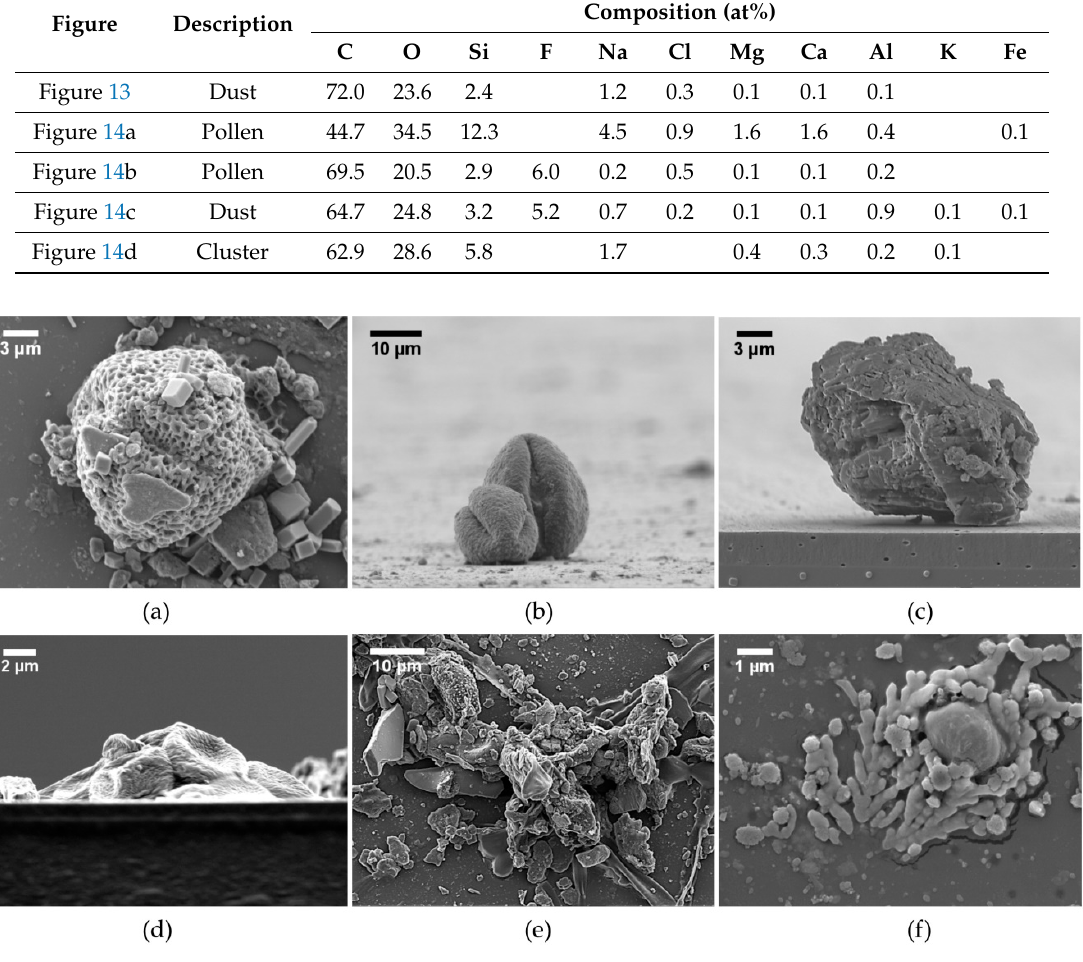
Figure 14. A variety of cementation structures have been observed. ( a ) Pollen with salt crystals on uncleaned uncoated A coupon at week 12, ( b ) pollen on uncleaned coated A at week 15.3, ( c ) dust on coated A cleaned at week 8, ( d ) cluster on coated uncleaned B coupon at week 24, ( e ) cluster on uncleaned coated B at week 20, and ( f ) cluster on coated uncleaned A at week 12.